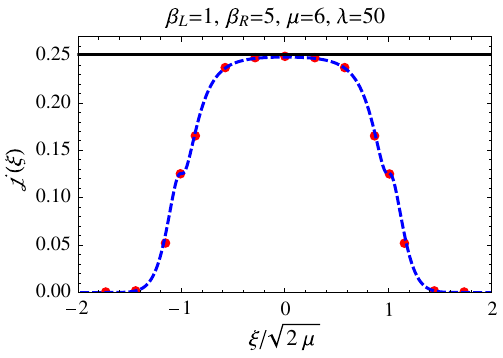
FIG. 7. Energy current in the Lieb-Liniger model for low temperatures, large coupling, and chemical potential μ ¼ 6 (circles). Local stationary points occur at α ffiffiffiffiffi p ξ ¼ (cid:4) 2 μ ¼ (cid:4) 3 . 46 (the Fermi velocity). The dashed curve represents the current [Eq. (47)] for the same temperatures and chemical potential, whose profile is not dissimilar to the plots shown in Fig. 5. As before, the bold horizontal line is the CFT 1 − 1 value π . The agreement is extremely 12 ð 25 Þ